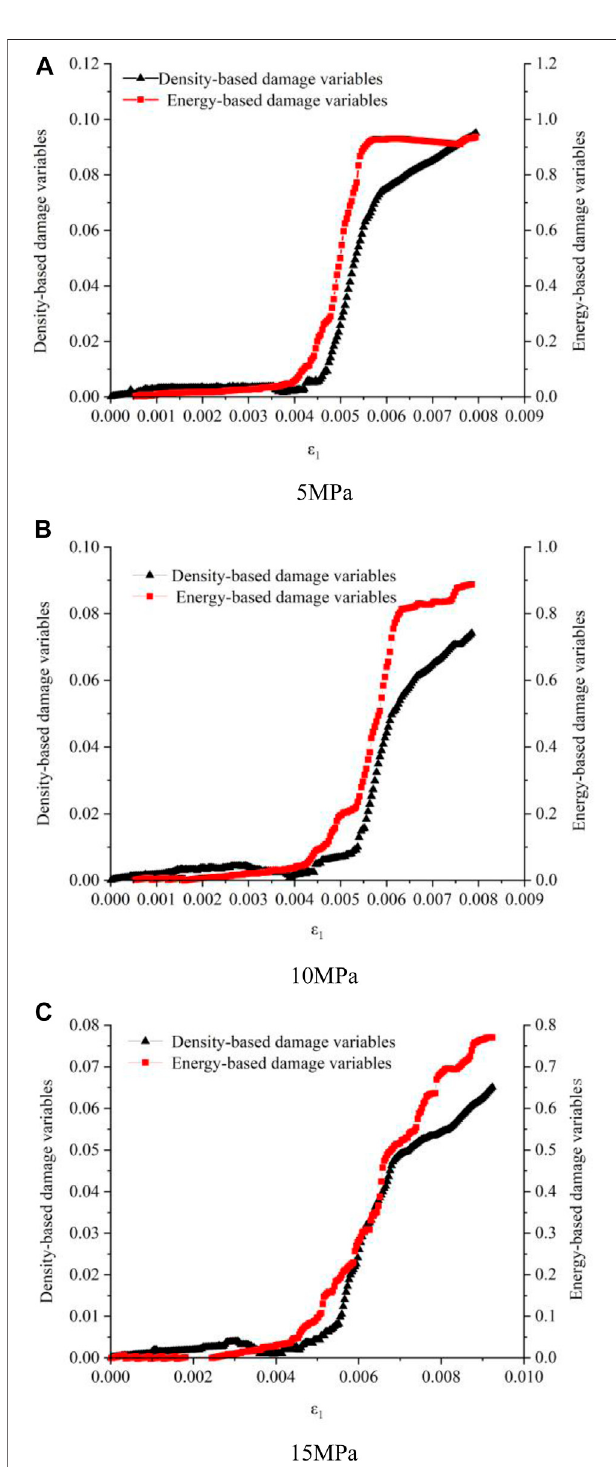
FIGURE9| Damagevariableevolutionoftwocalculationmethodsunder different con fi ning pressures.